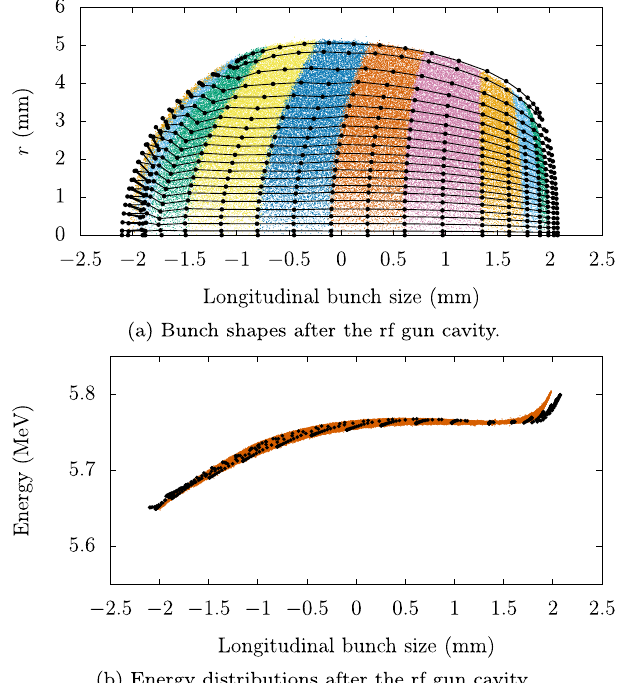
FIG. 7. Beam dynamics calculated using the new code for a charge of 1.0 nC per bunch in the BNL-type rf gun cavity.